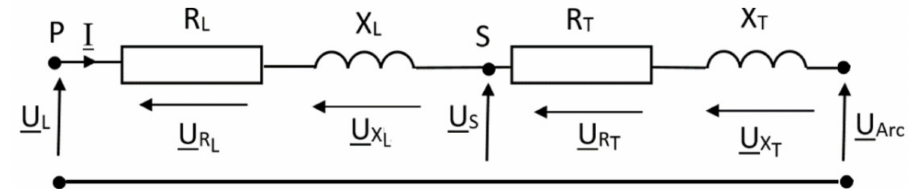
Figure 4. Single-phase power supply scheme for an arc